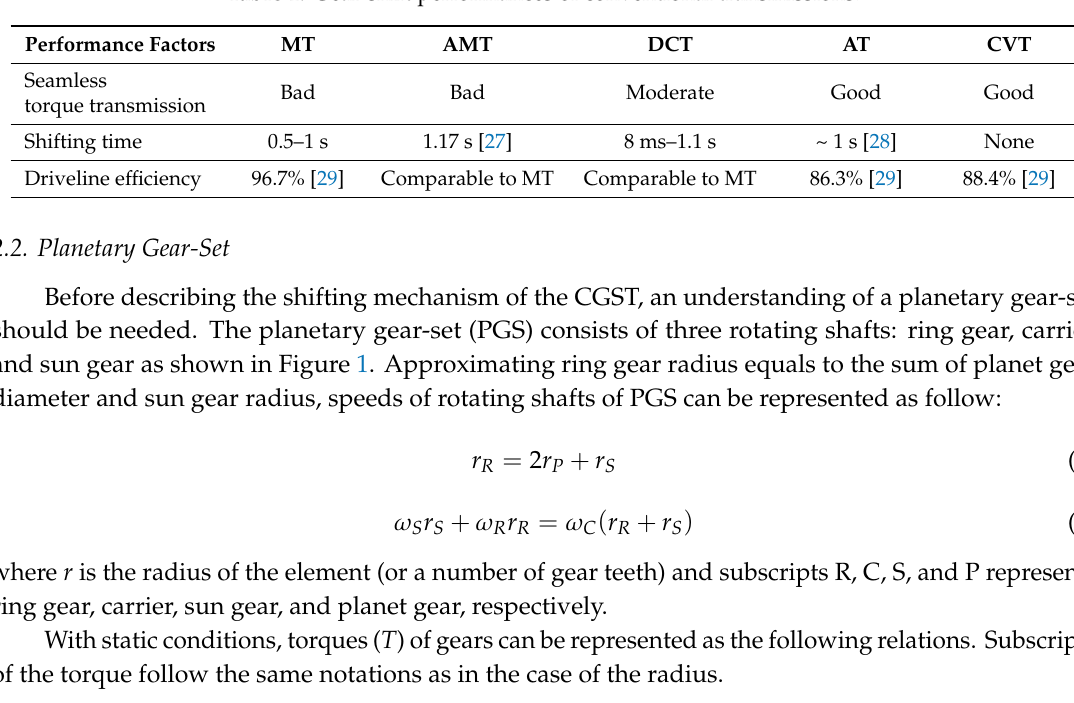
Table 1. Gear-shift performances of conventional